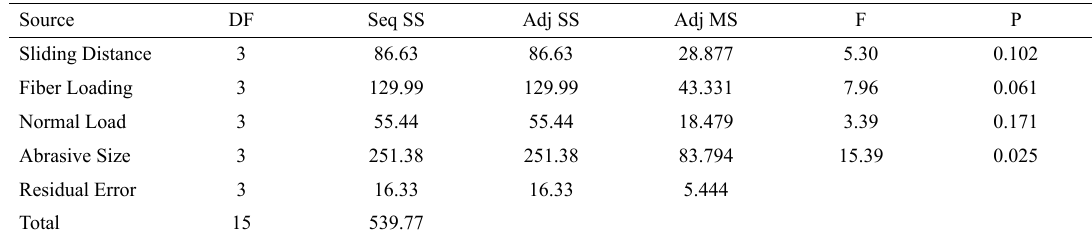
Table 5. ANOVA for specific wear rate of untreated jute fiber–epoxy composites